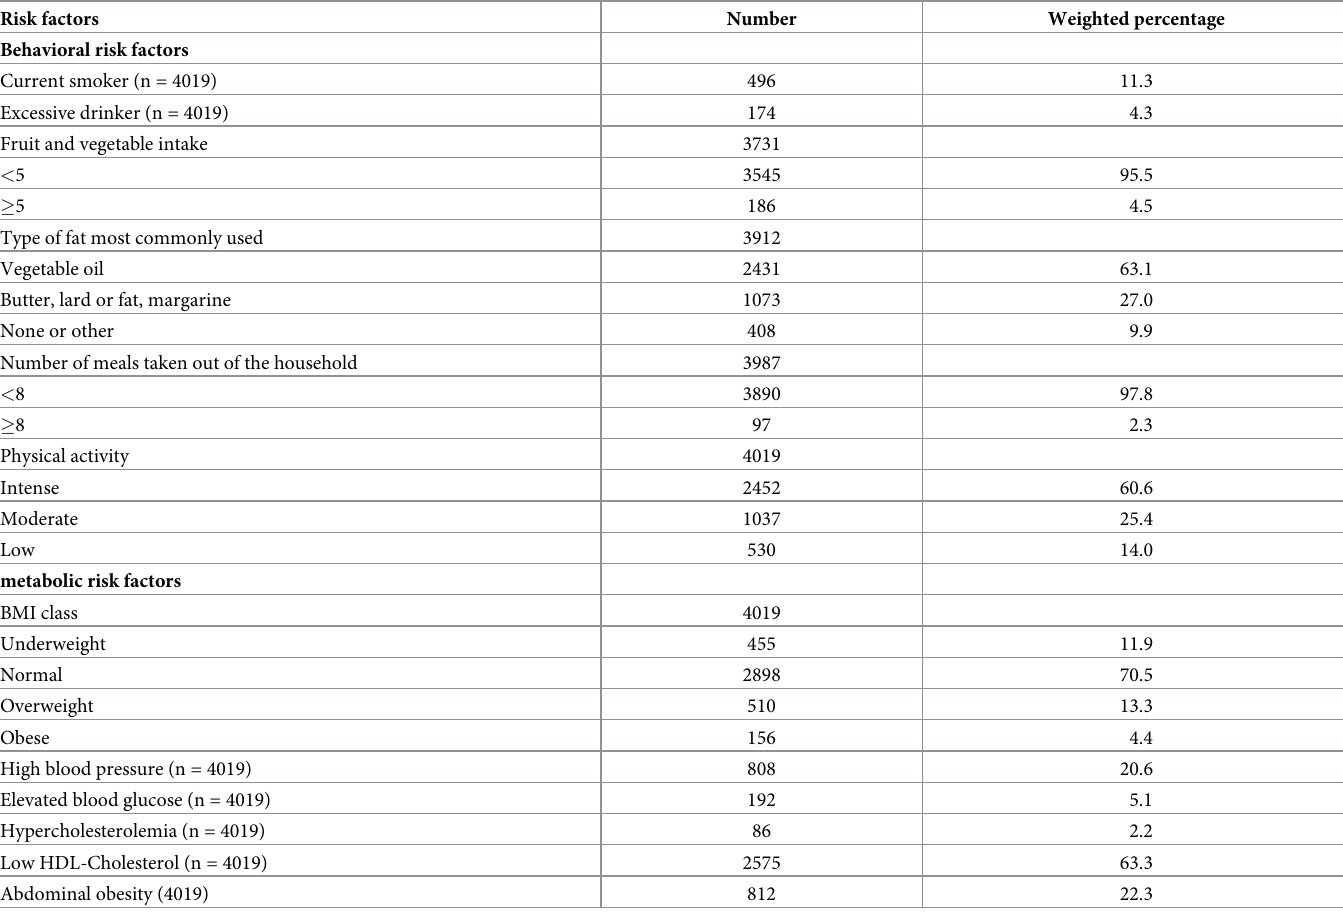
Table 3. Descriptive behavioral and metabolic characteristics of risk factors among the study